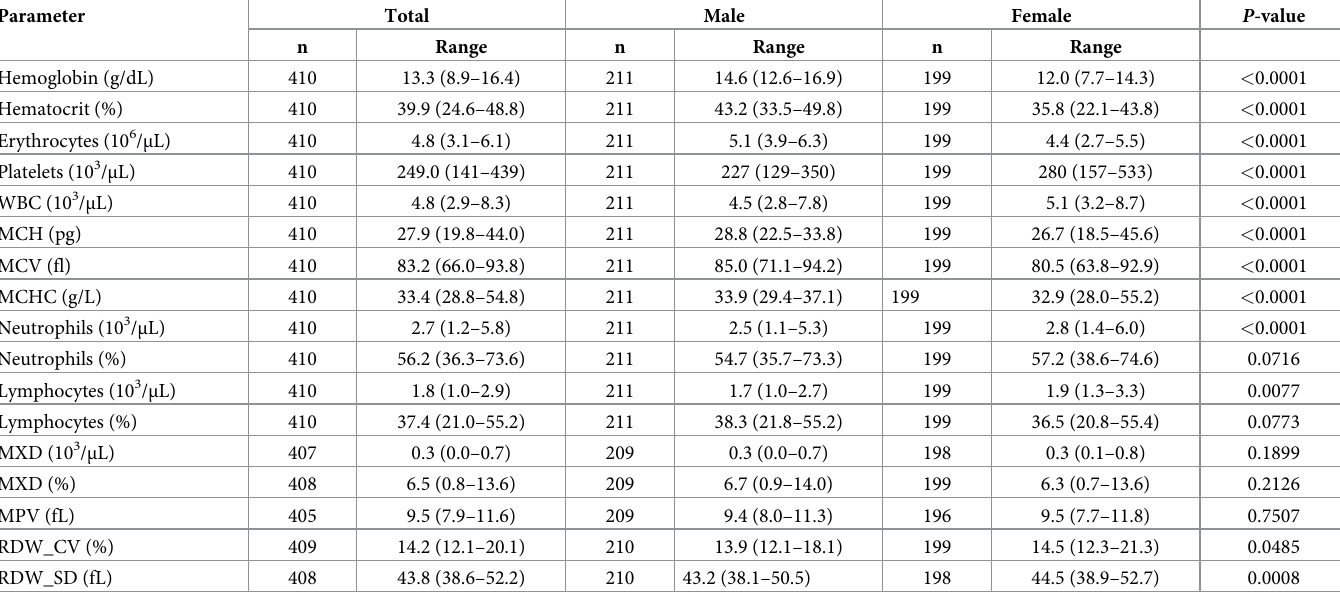
Table 1. Hematology reference values (median and 2.5 th - 97.5 th percentiles) derived from healthy adults at high-risk for HIV in